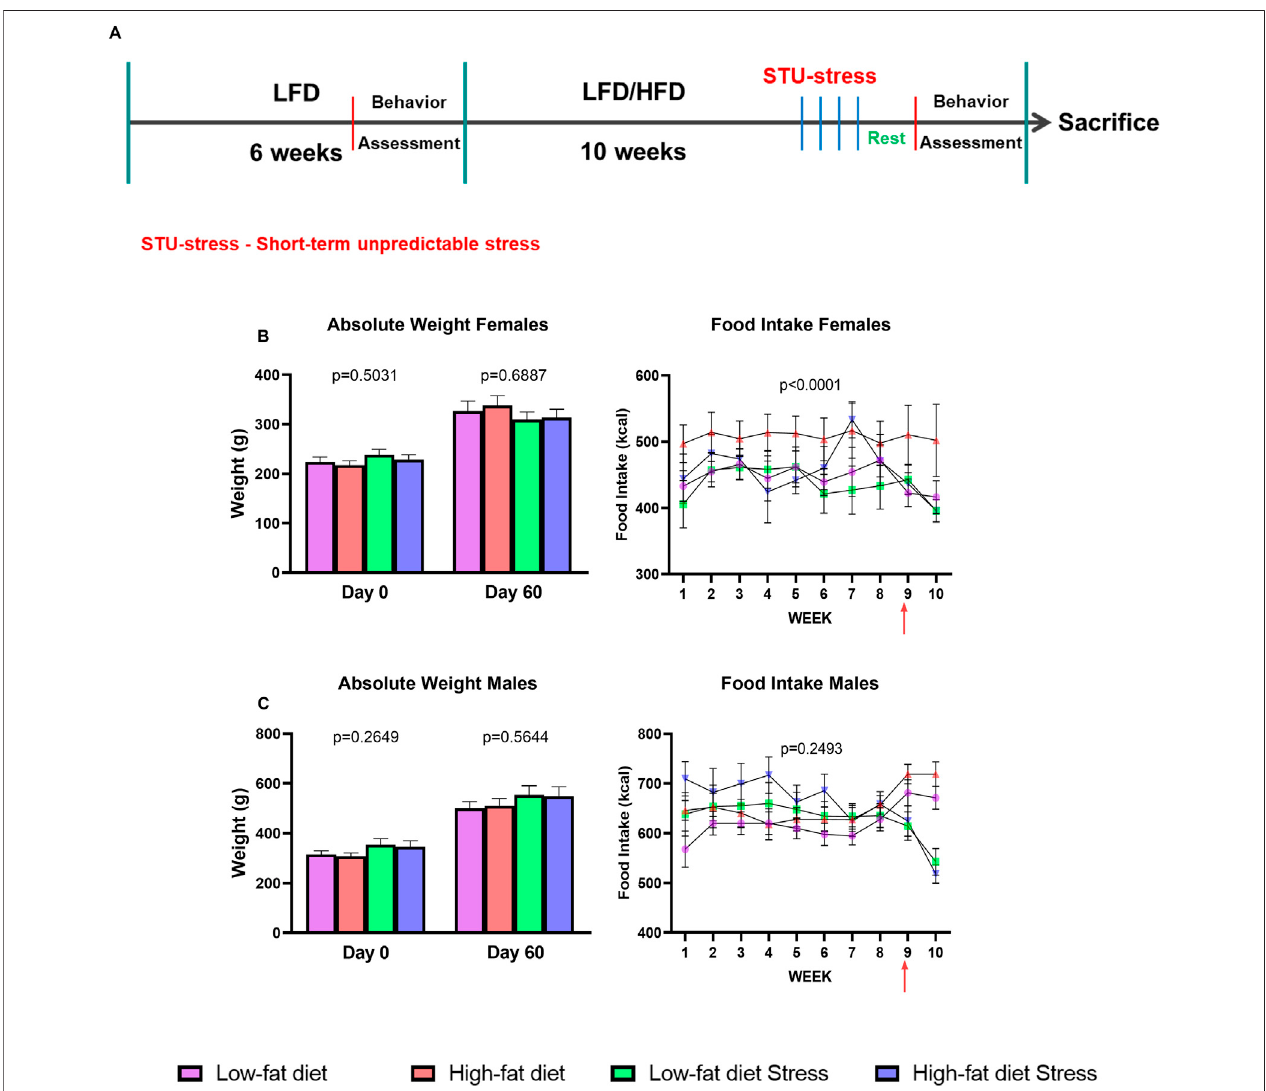
FIGURE 1| Experimental timeline and effect ofHFD and/or STU stress on absolute weight and food intake . (A) Timeline ofthe exposureof male and female rats to LFD, HFD, and STU stress. (B) Absolute weight and food intake of female rats. Red arrow on food intake graph indicates the inclusion of the STU stress paradigm. (C) Absolute weight and food intake of male rats. Data represented as mean ± SEM. Red arrow on food intake graph indicates the inclusion of the STU stress paradigm. Samplesizeforfemalerats: LFD=12,HFD=12, LFDS=12,andHFDS =12.Samplesizeformale rats: LFD=12,HFD=12,LFDS=12, andHFDS =11.Statistic used, One-way ANOVA with Tukey ’ s multiple comparison test for absolute weight analysis. One-way ANOVA with repeated measures for food intake analysis.